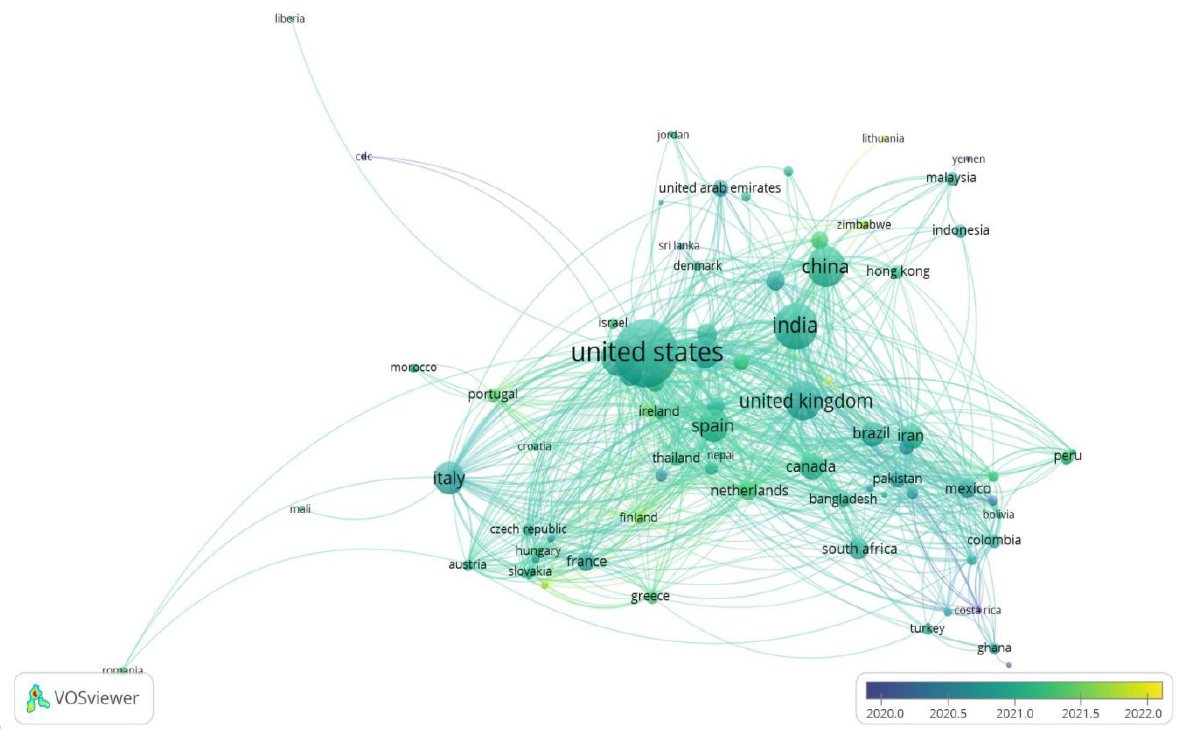
Figure 6. Countries’ coupling/collaboration based on the average number of publications per year in the WoS and Scopus databases.